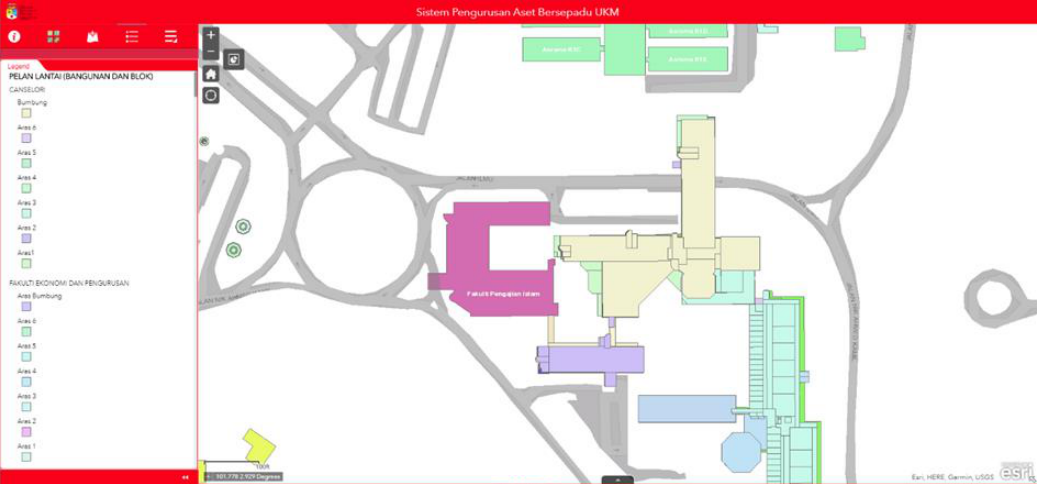
This system module has two different GUI; operational level (Figure 17) and new dashboard view for the decision makers (top management) as illustrate in Figure 18.